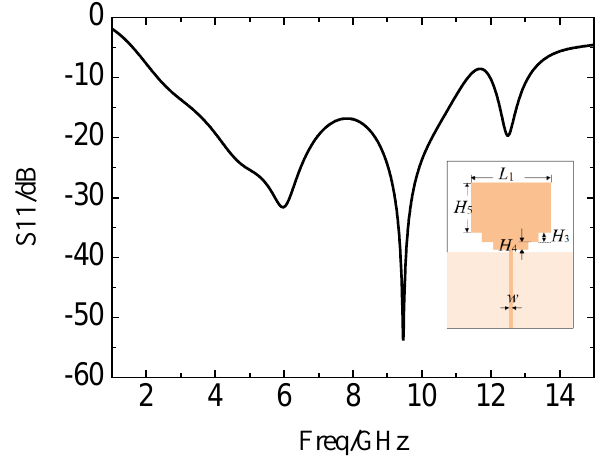
Figure 5. Simulation results of the reflection coefficient curve of the antenna after adding SIR structure.